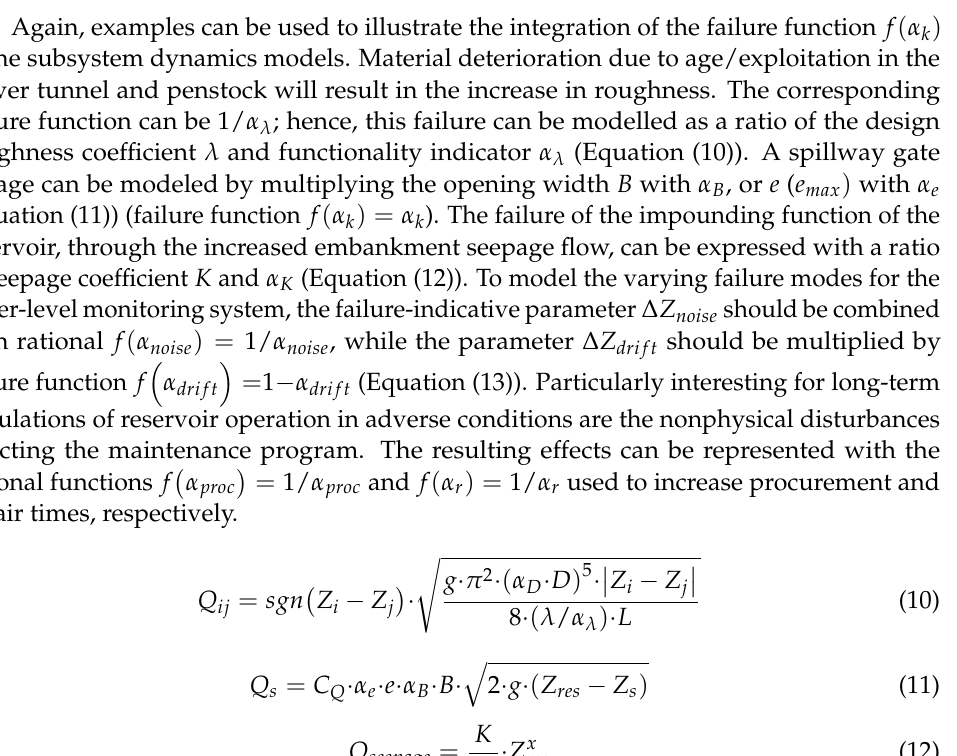
Figure 3. Example functionality indicator α time-series, representing generic failures in three elements due to the two disturbances.